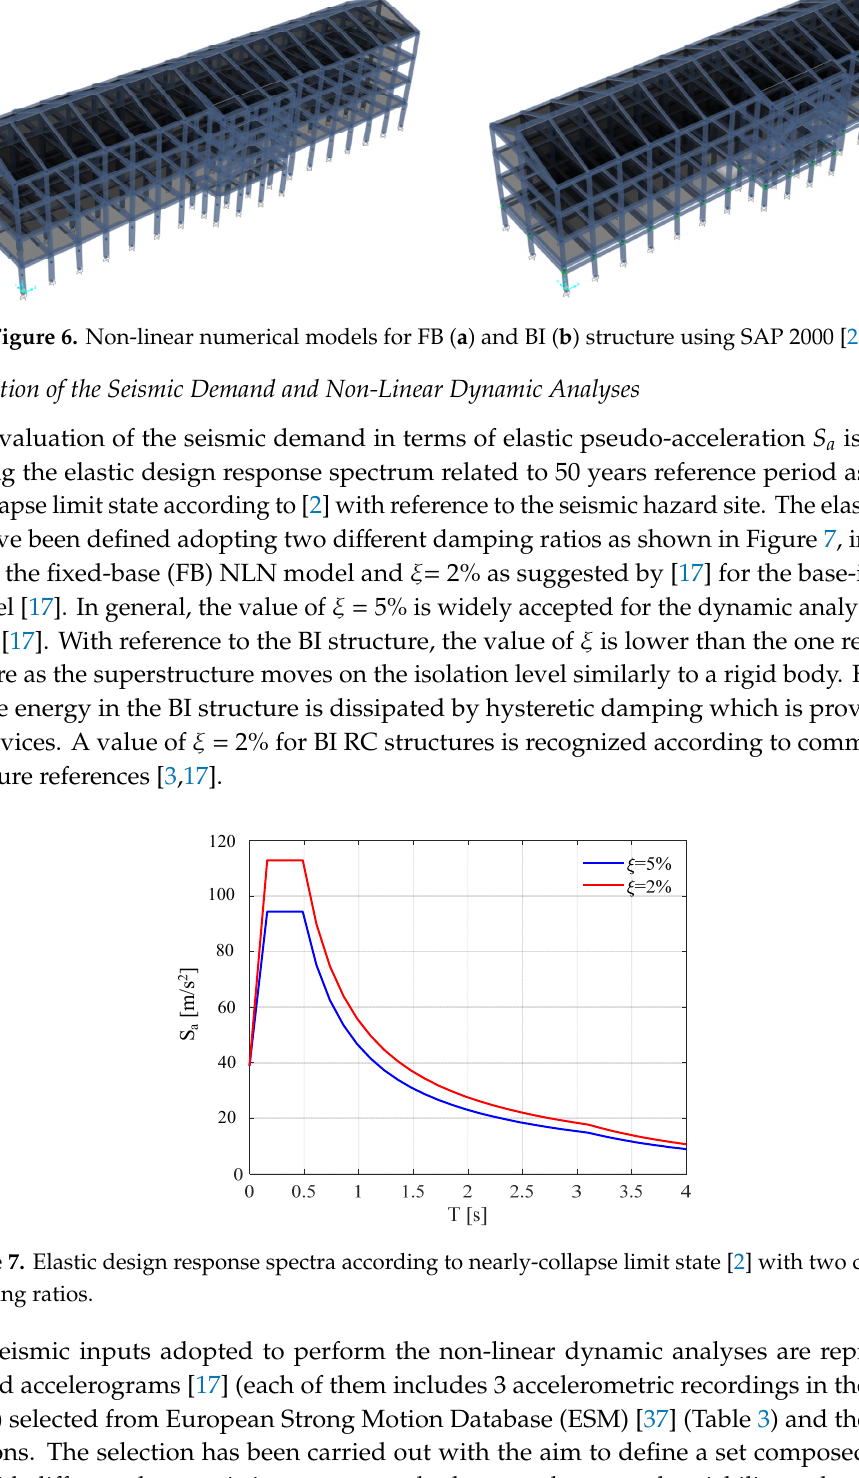
Figure 5. Location of the adopted FP devices in plan.